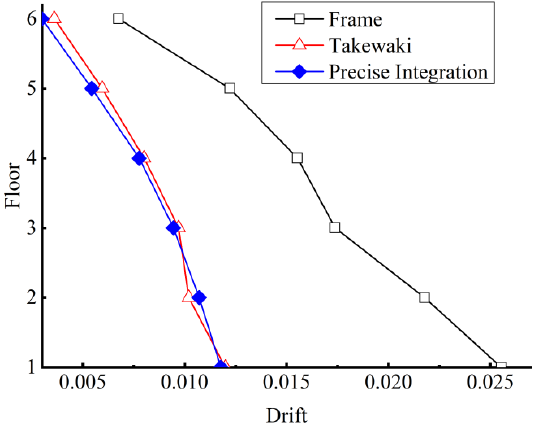
Figure 7. Six-story shear frame: Story drifts by different response calculation methods [25].